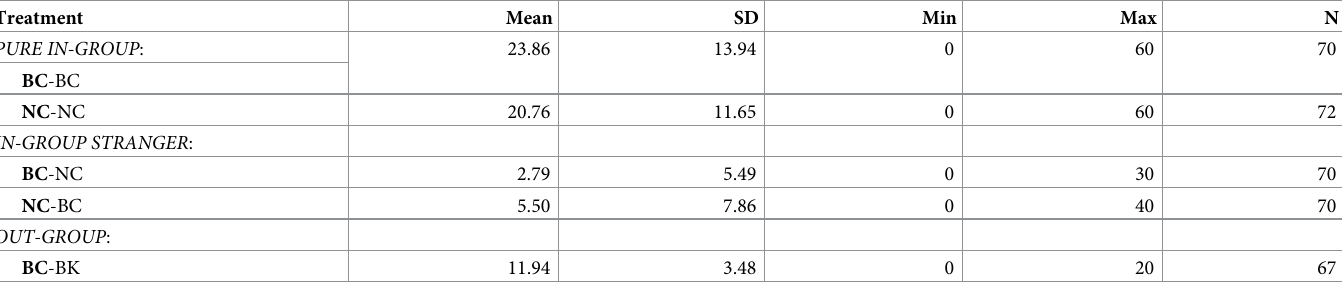
over VND 5,000 compared with 94.3% (panel a) and 97% (panel e) of Marie Curie and Minh Khai bilinguals, respectively. Conversely, whereas Marie Curie non-bilinguals sent more than or equal to VND 20,000 (one-third of the initial endowment) to about 66.8% (panel b) of their Table 2. Summary statistics of the amount offered in Dictator Game, by treatment and session.